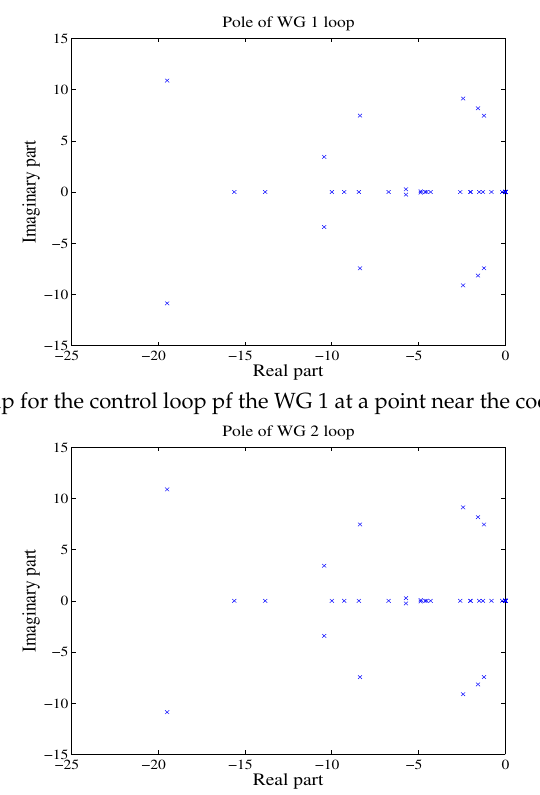
Figure 25. Pole map for the RTP loop at a point near the coordinate origin.